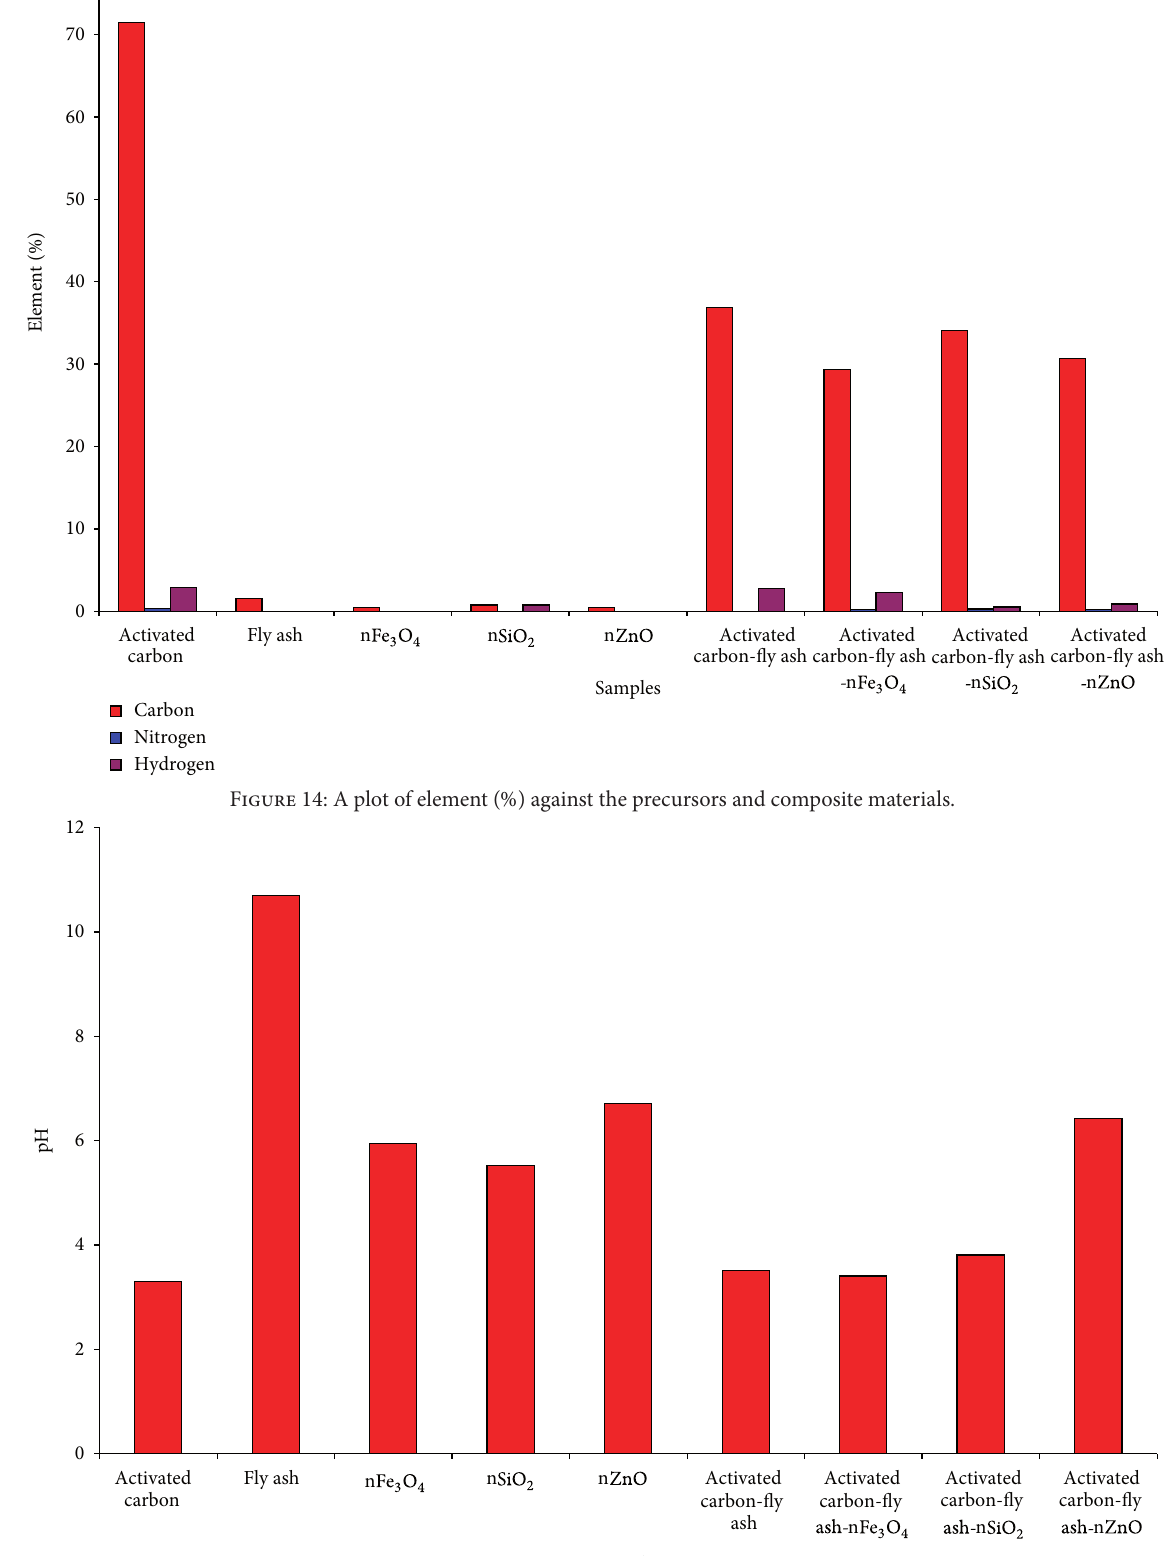
F 15: p� of acti�ated car�on� �y ash� nano metal o�ides� and composite